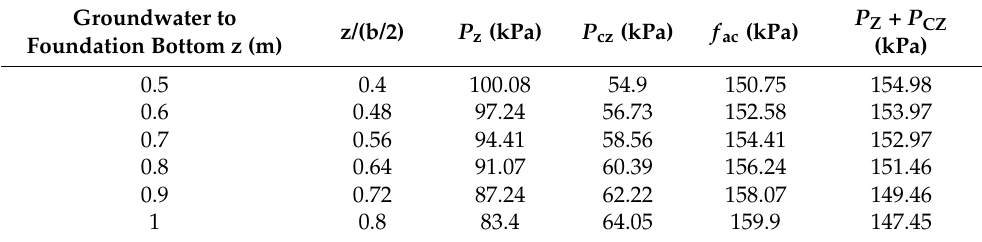
Table 8. Calculation results of foundation bearing capacity (b = 2.5 m, d = 2.5 m).